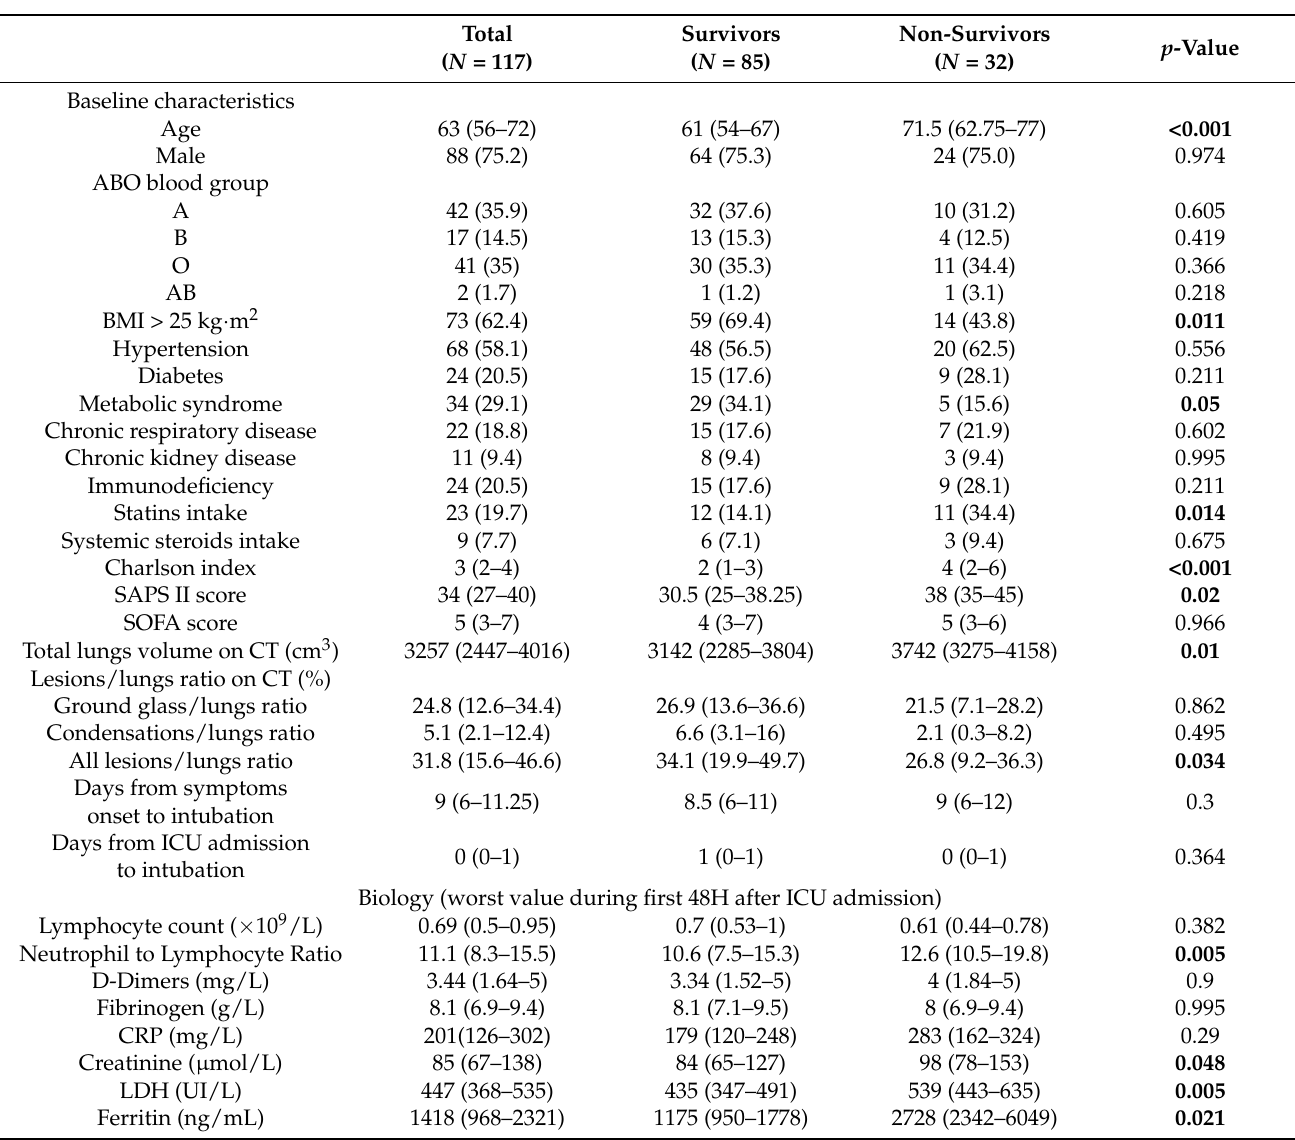
Table 1. Baseline characteristics of the 117 patients on invasive mechanical ventilation according to their 90-day survival